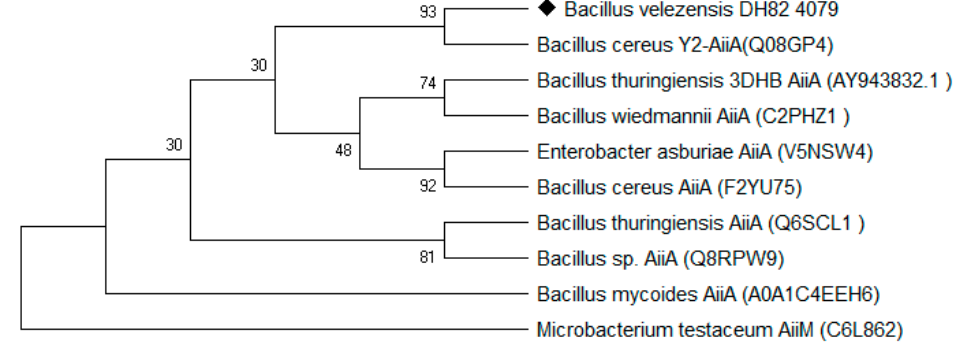
Figure 2. Neighbor-joining tree based on the AiiA from B. velezensis (DH82 strain).